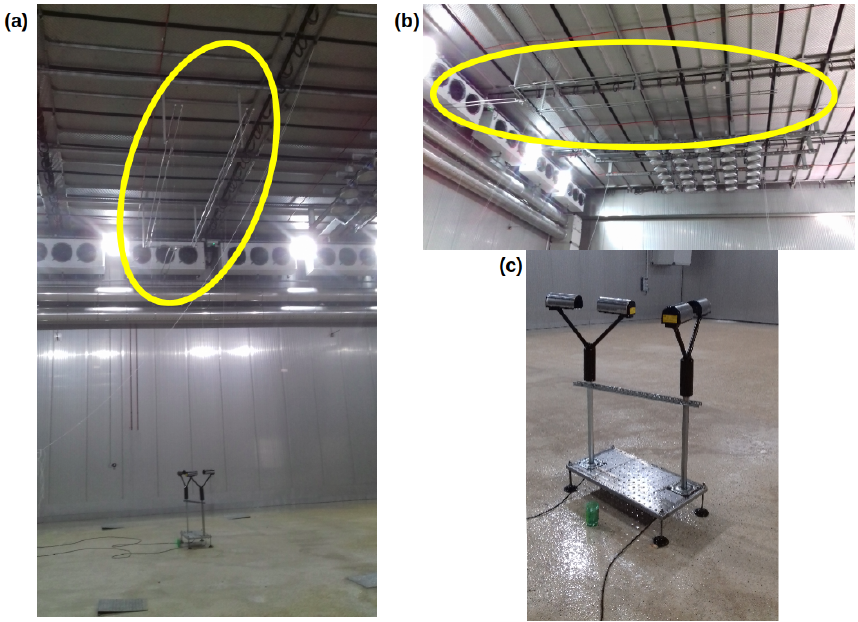
Figure 1. Pictures showing an overview of the measurement campaign (a) , a zoom on the rainfall simulator (b) , and the disdrometers (c) . The rainfall simulator, with its two separate networks for light and heavy rainfall, is indicated in